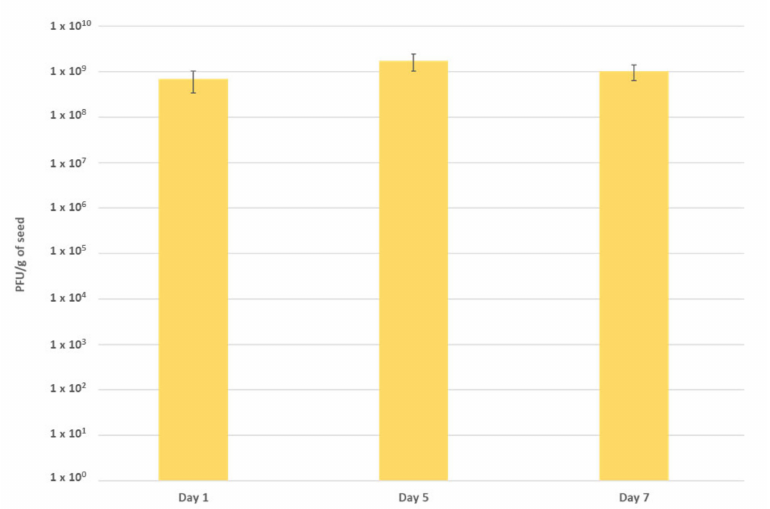
Figure A2. Phage titer (PFU / g) determined in noninfected seeds over a time period of seven days. The phage titer remains stable over the course of the seed priming (Day 7) at 10 9 PFU / g